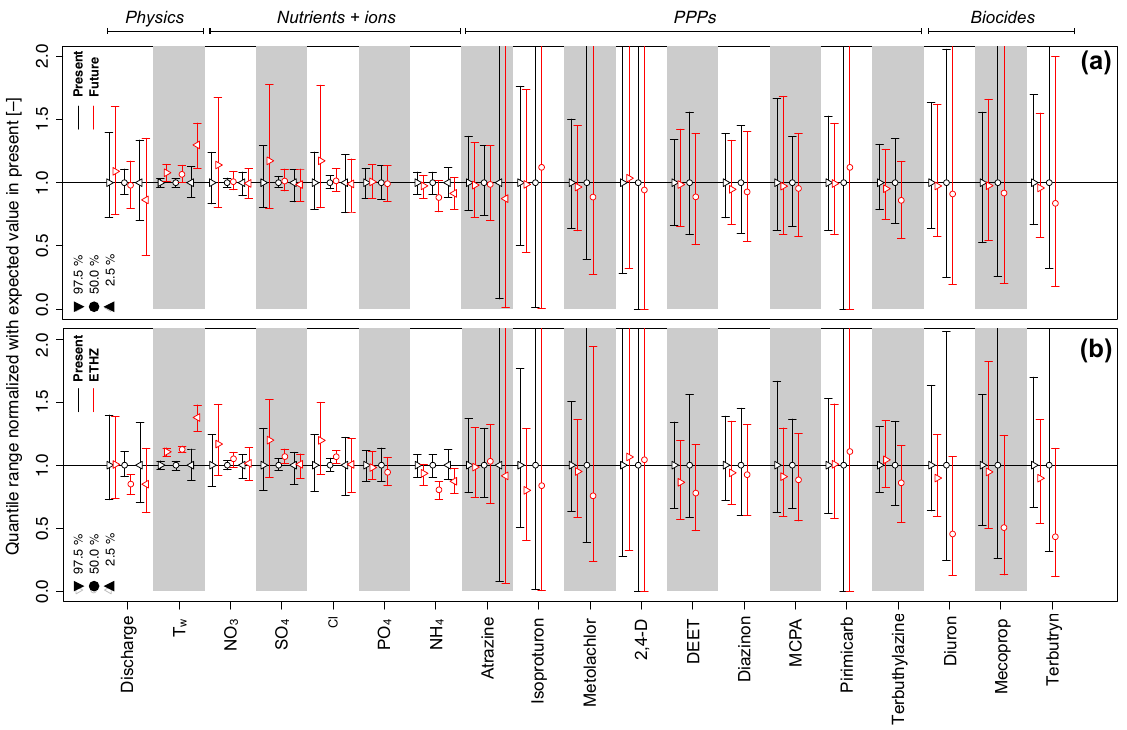
Figure 4. Relative change for high (Q97.5%), median (Q50%), and low (Q2.5%) quantiles of predicted model variables. ( a ) Reference (calibration) period vs. ensemble future climate (assuming status quo + CurrPrac in both cases). ( b ) Reference period vs. future according to the ETHZ HadCM3Q0 CLM model chain (drier climate) (assuming status quo + CurrPrac in both cases). Missing low quantiles correspond to cases where a present expected value of 0 for the low quantile prevented the meaningful normalization of